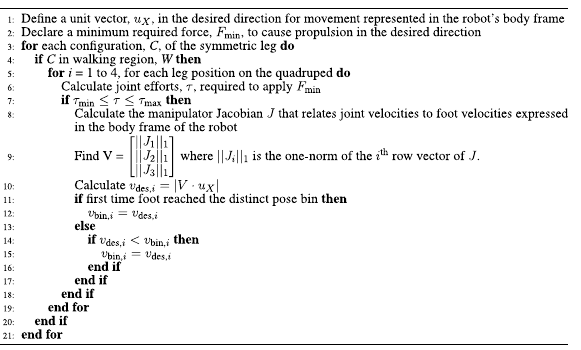
Algorithm 3. Average Desired Velocity Metric Approximation